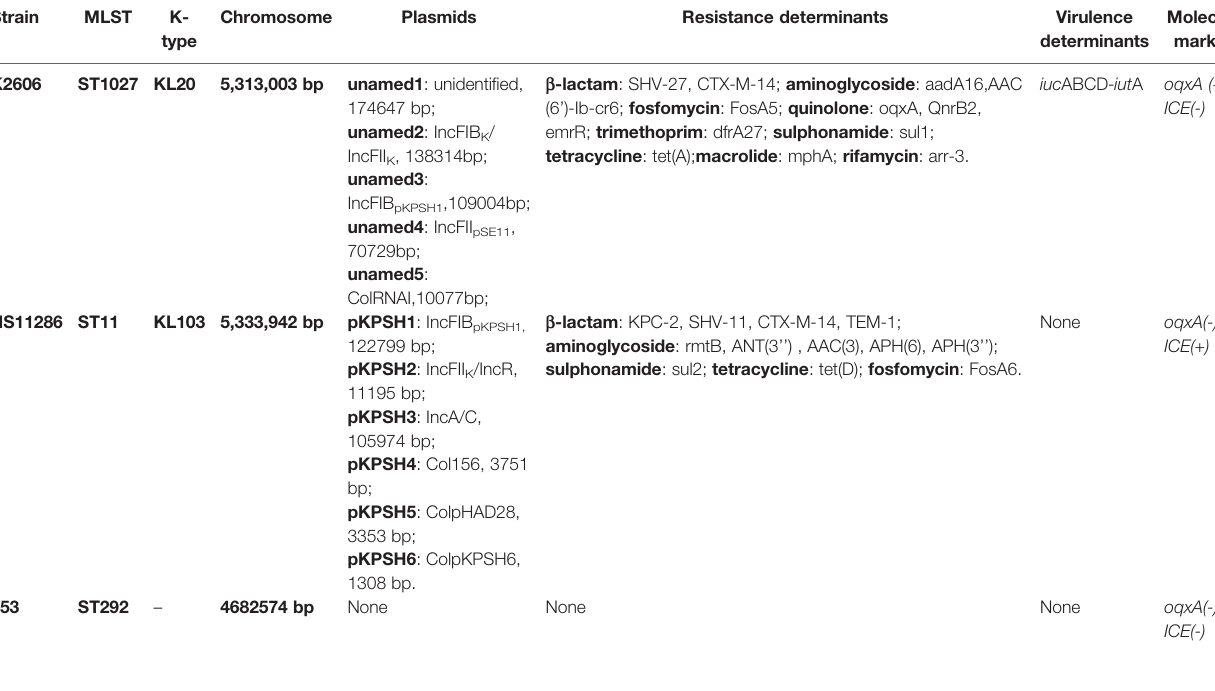
TABLE 1 | Genomic characteristics of K2606, HS11286, and